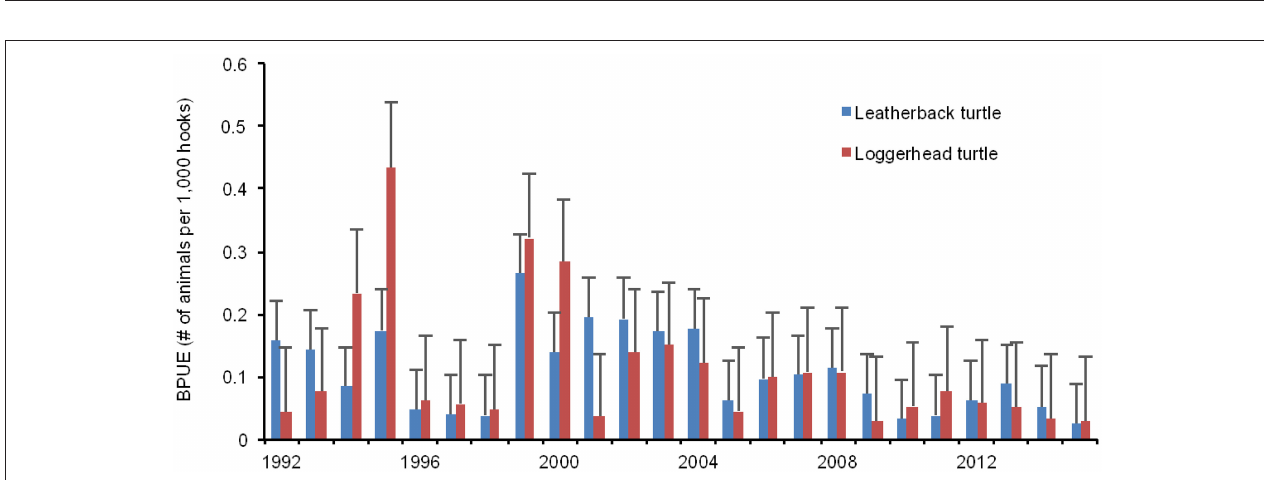
FIGURE 3 | Atlantic data Sea turtle bycatch per unit effort (BPUE, #individuals caught per 1,000 hooks, ± SD) by year.